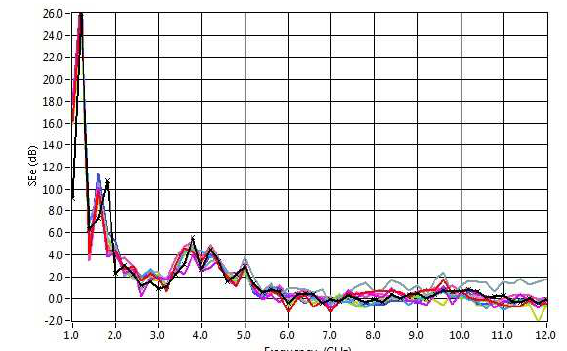
Figure 12: Uncorrected SE e from measurements of 5 mm mesh size enclosure; 10 independent measurement configurations; 1000 independent samples at each frequency point.